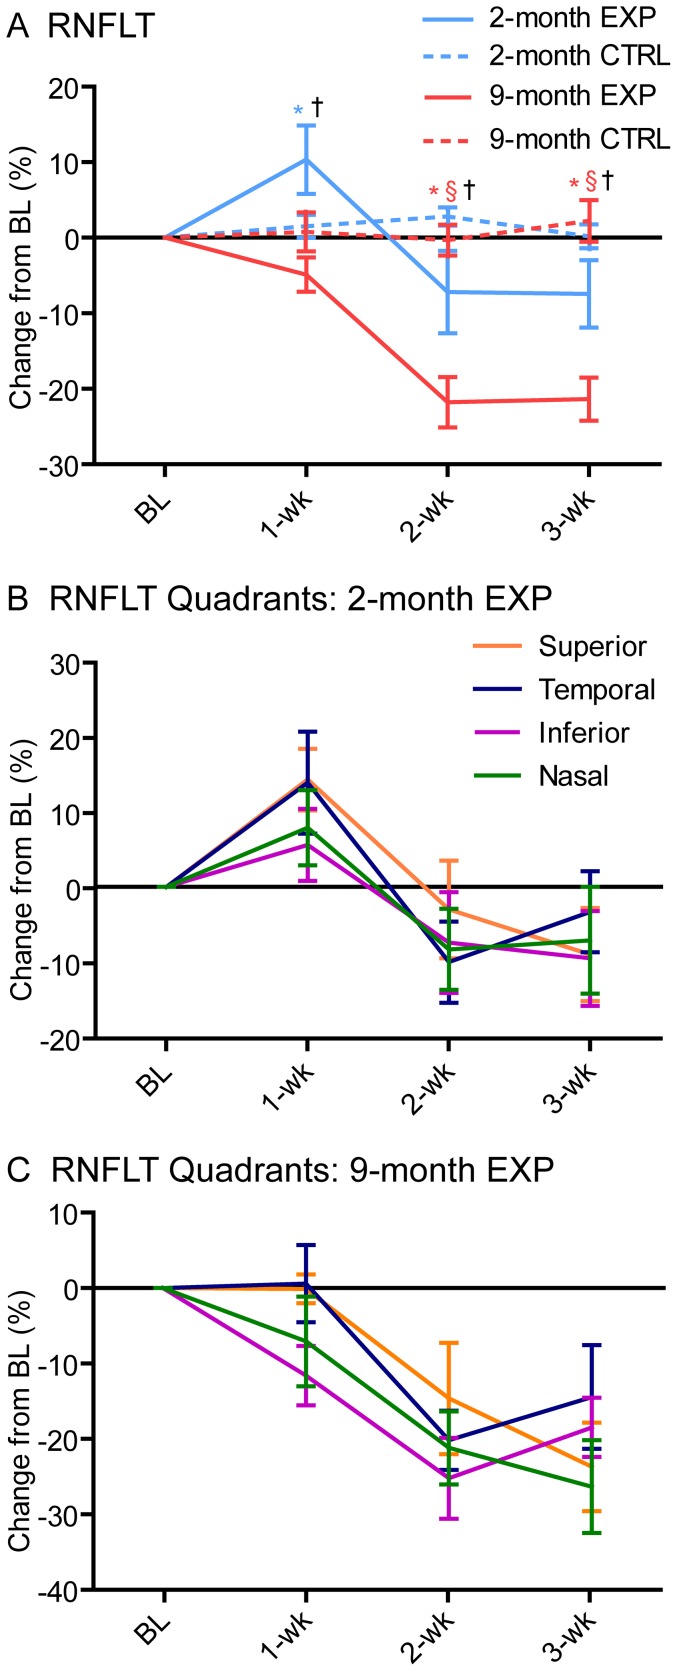
Percent change in RNFLT relative to baseline.(A) Change in total peripapillary RNFLT for experimental and fellow control eyes in both age groups. The 2-month group experimental eyes exhibit initial RNFL thickening, followed by thinning, while the 9-month group experimental eyes only exhibit thinning and do so to a greater extent than the younger eyes. (B) Change in RNFLT across quadrants for 2-month experimental eyes. (C) Change in RNFLT across quadrants for 9-month experimental eyes. There was no significant difference between quadrants in either age group although the superior and temporal quadrants trended thicker than inferior and nasal quadrants at earlier time points. Error bars  =  SEM. * indicates p<0.05 when compared to baseline, § indicates p<0.05 when compared to fellow control eyes, † indicates p<0.05 when comparing 2-month and 9-month experimental eyes (Bonferroni). Legend in B also applies to C. Abbreviations: EXP  =  experimental eyes, CTRL  =  fellow control eyes, BL  =  baseline.